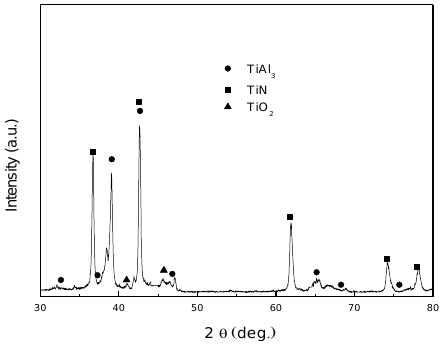
Figure 2. X-ray diffraction analysis (XRD) pattern of the nanoparticles synthesized from the master alloy of Ti–48Al by HPMR in N 2 , H 2 , and Ar atmosphere.